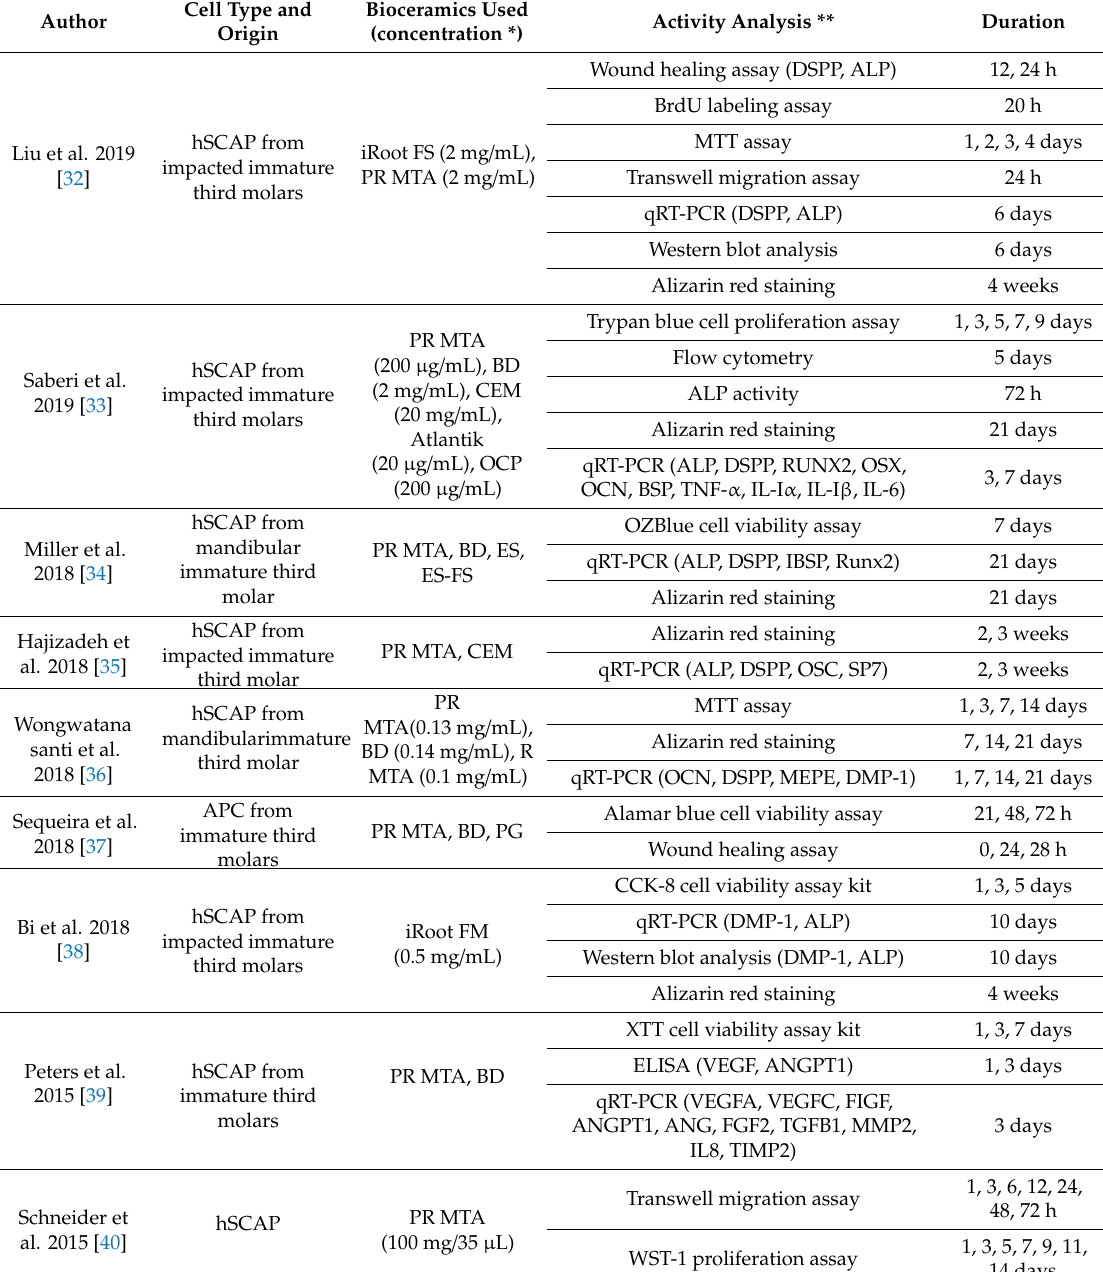
Table 1. Summary of the methodology of included